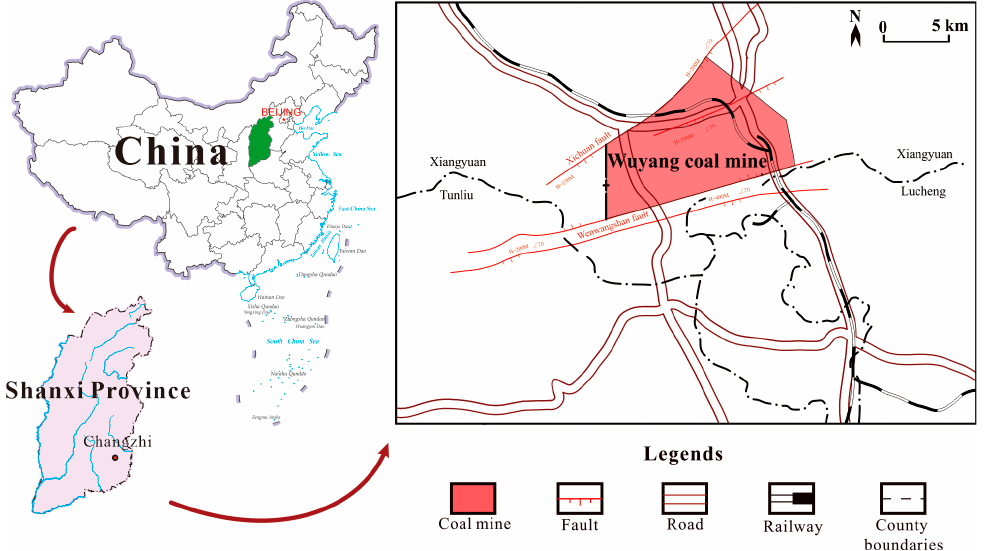
Figure 1. Location of the study area.